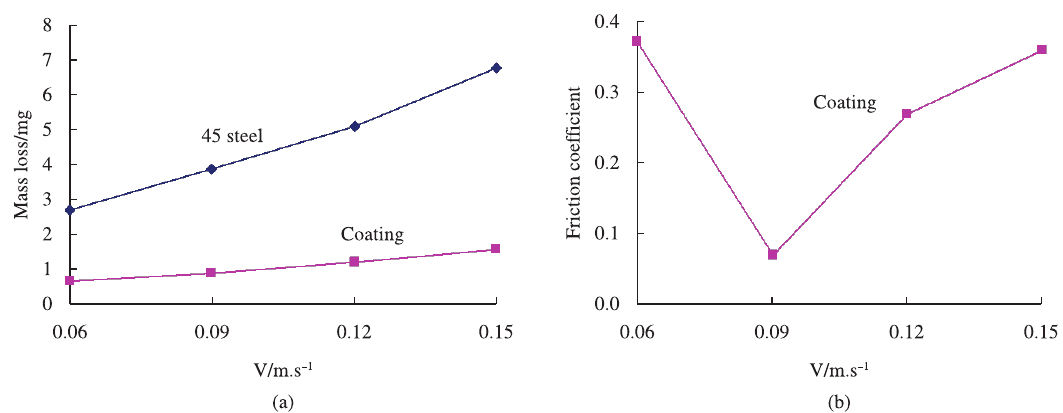
Figure 6. Mass loss and friction coefficient variation versus rubbing speed at 10 N. (a) Mass loss at 10 N; (b) Friction coefficient at 10